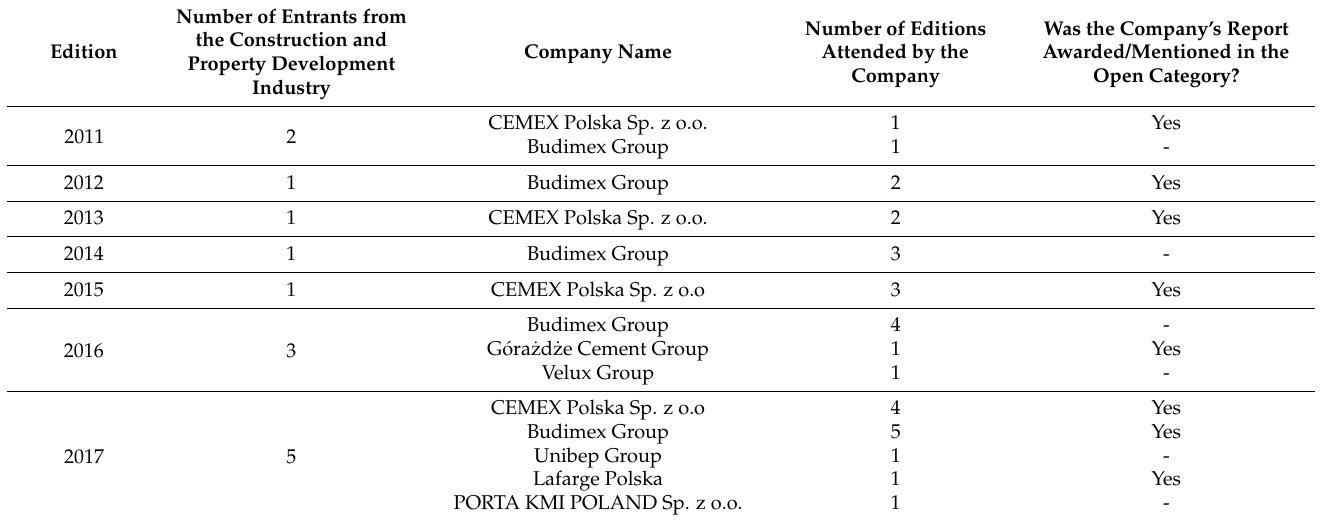
Table A1. General overview of construction and property development enterprises participating in the best CSR report